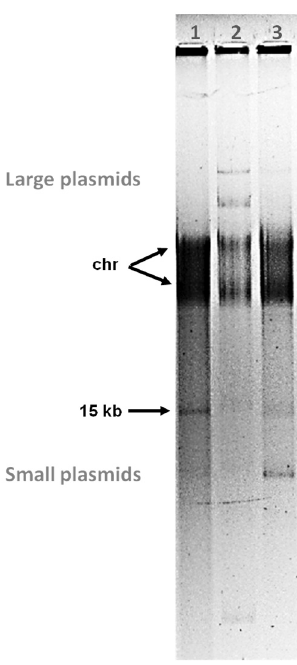
Figure 2. Plasmid(s) electrophoresis profiles of strains (1) B. thuringiensis GBJ002/GIL16; (2) emetic B. cereus AND1284; and (3) B. cereus s.l. VD166, harboring plasmidial tectiviruses GIL16, Sato and Sole, respectively. The tectiviral prophages in a linear plasmid state (~15 kb) are indicated. chr, linearized chromosomal DNA.